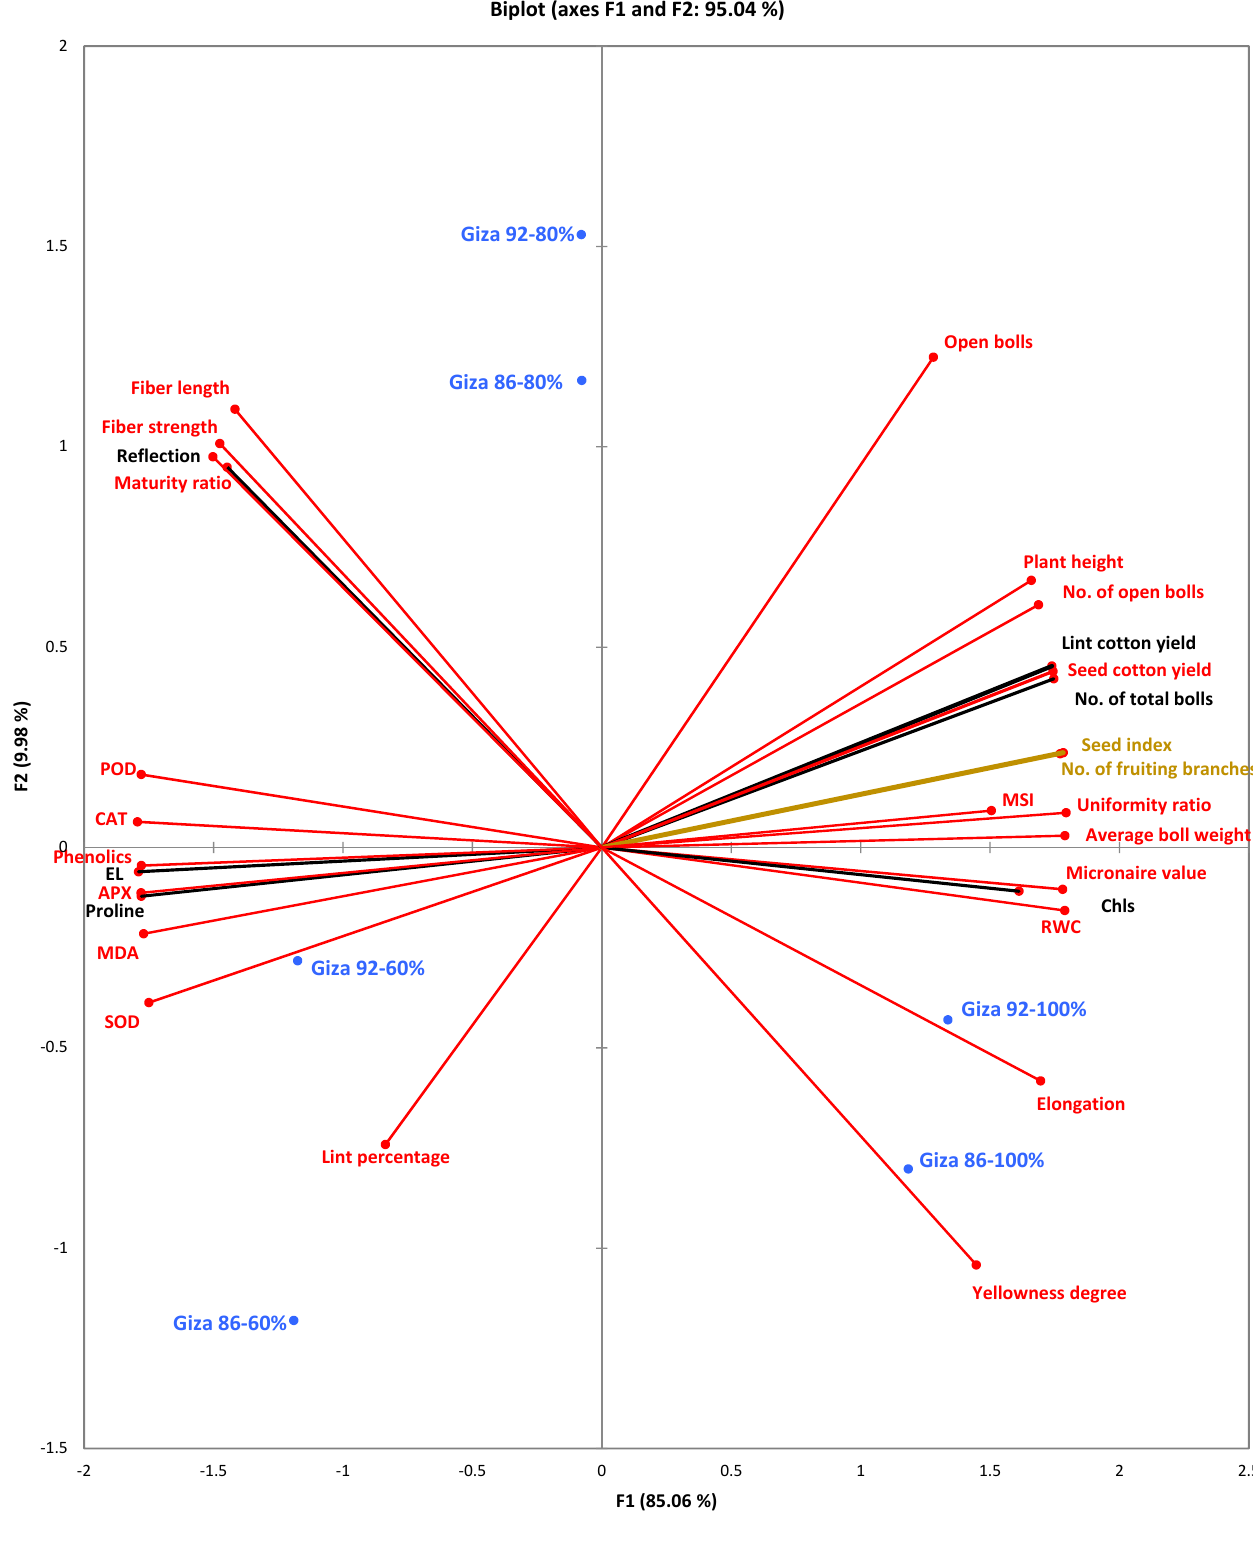
Figure 1. Biplot of the principal components analysis representing the relationship among the evaluated physiological traits and antioxidants and their roles in yield components and quality traits.